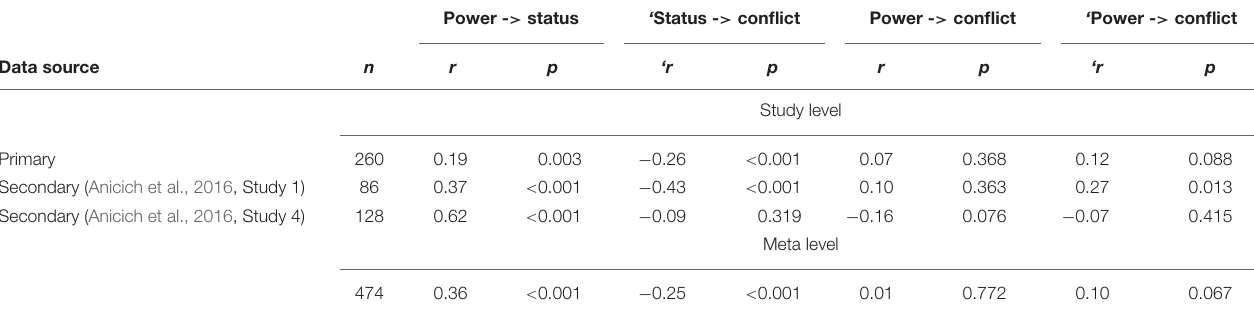
TABLE 1 | Study-level and meta-level pathways predicting conflict from power and status (Study